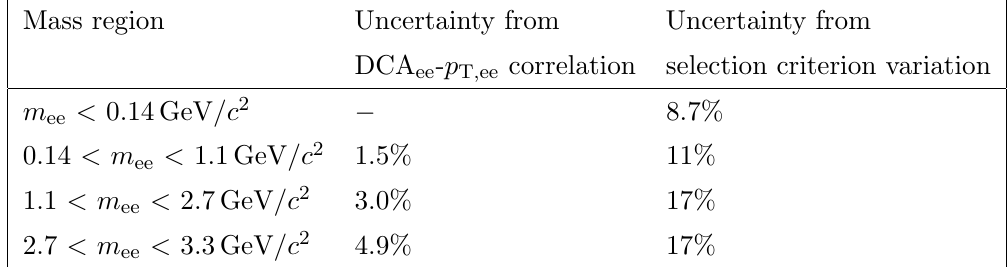
Table 2 . Summary of the systematic uncertainties for the DCA ee analysis ( p T ; e > 0 : 4 GeV/ c and j (cid:17) e j < 0 :